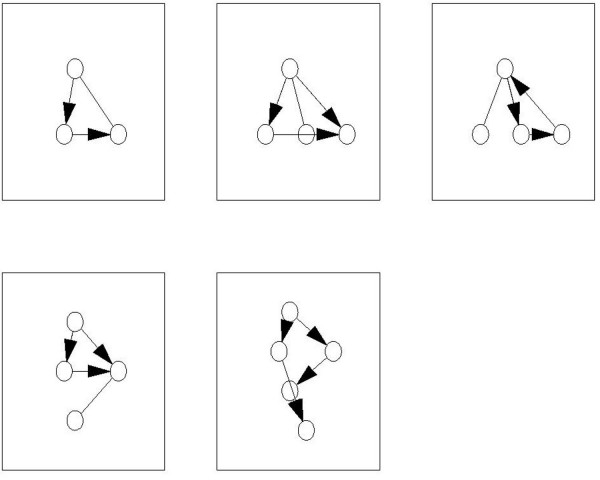
Subgraphs associated with nnz D AUT AUT AU AUT A. Every word can be associated with a set of subgraphs. If the word has a non-zero value for a given network, at least one of these subgraphs must appear. The figure shows the subgraphs associated with the word nnz D AUT AUT AU AUT A.